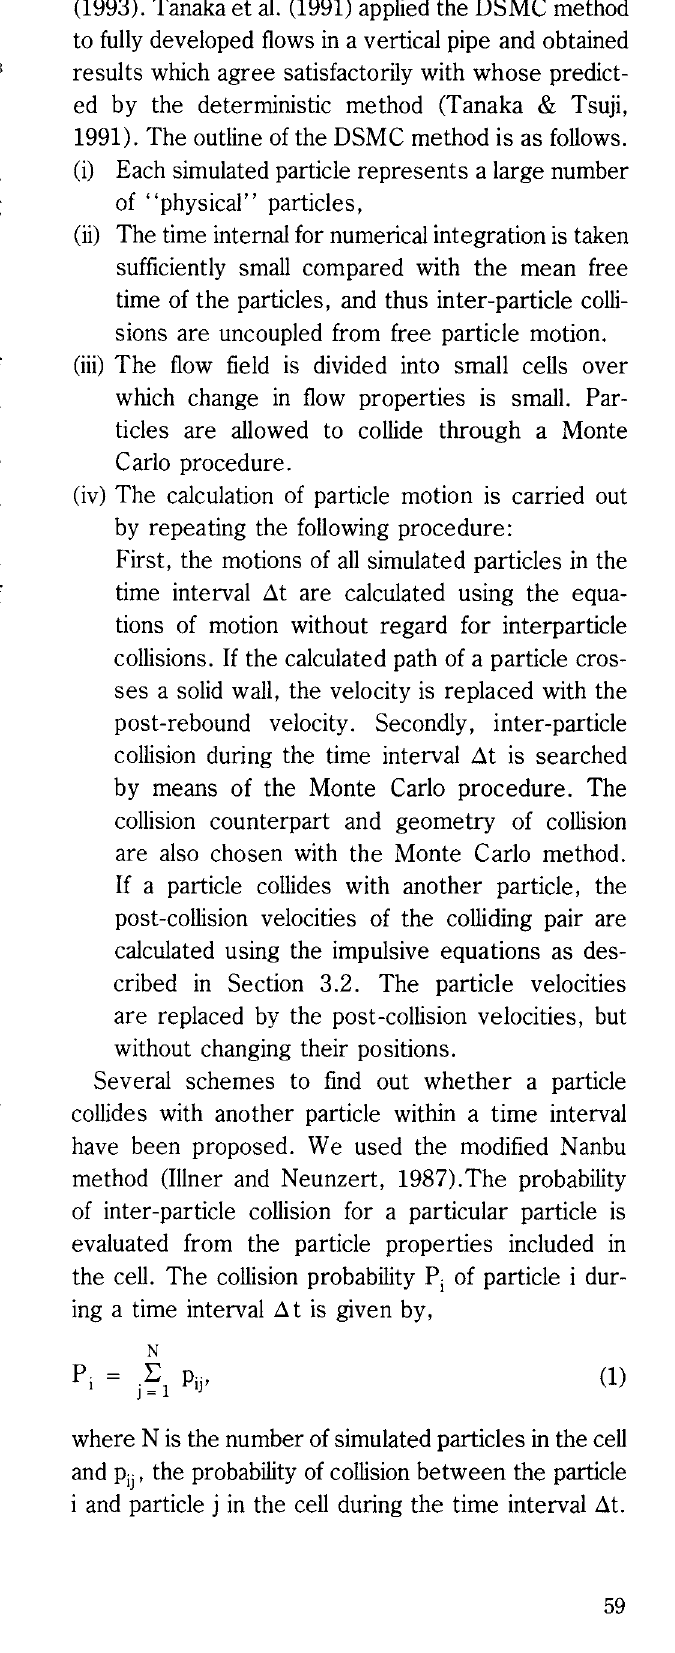
Fig. 2 Trajectories of a particle in a horizontal channel Particle size = 1.1 mm, Particle density = 1038 kg/m 3 Restitution coefficient e = 0.93, Friction coefficient J1 r =